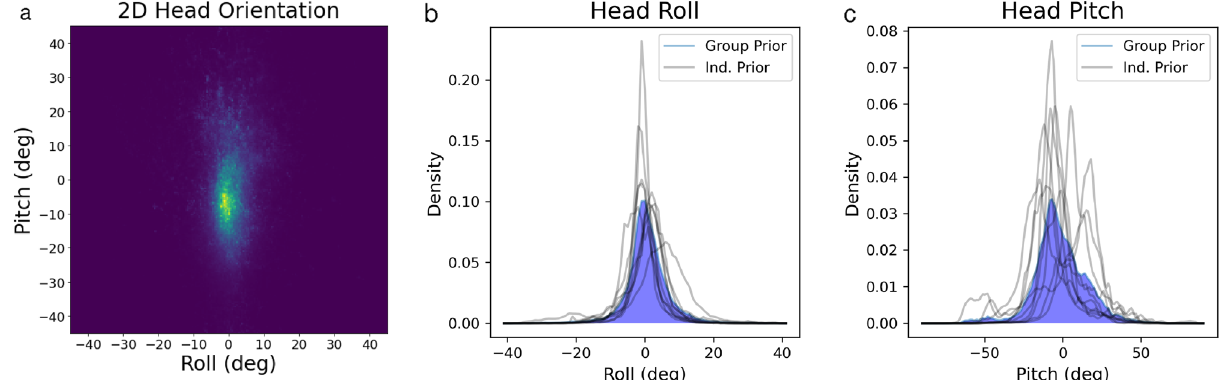
Figure 2. 2D head orientation measured across all participants ( a ). Marginal KDEs for roll ( b ) and pitch ( c ) are also plotted. The KDEs plotted in blue represent the distributions across all participants, while black traces represent KDEs for individual